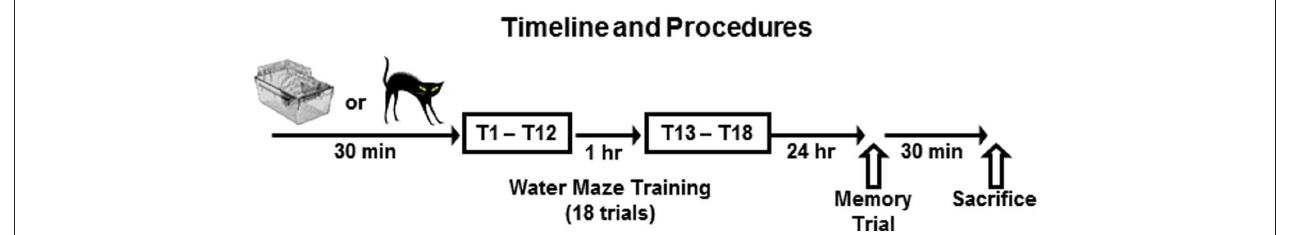
Figure 1 | experimental timeline. The experimental procedures took place over 2 days. On day 1, rats were brought to the laboratory and then remained in their home cages (Standard Training) or were placed in close proximity to a cat (Pre-Training Stress) for 30 min immediately before training in the radial-arm water maze. The training protocol on Day 1 consisted of a total of 18 trials of training which were administered in 12 sequential trials (T1–T12), followed 1